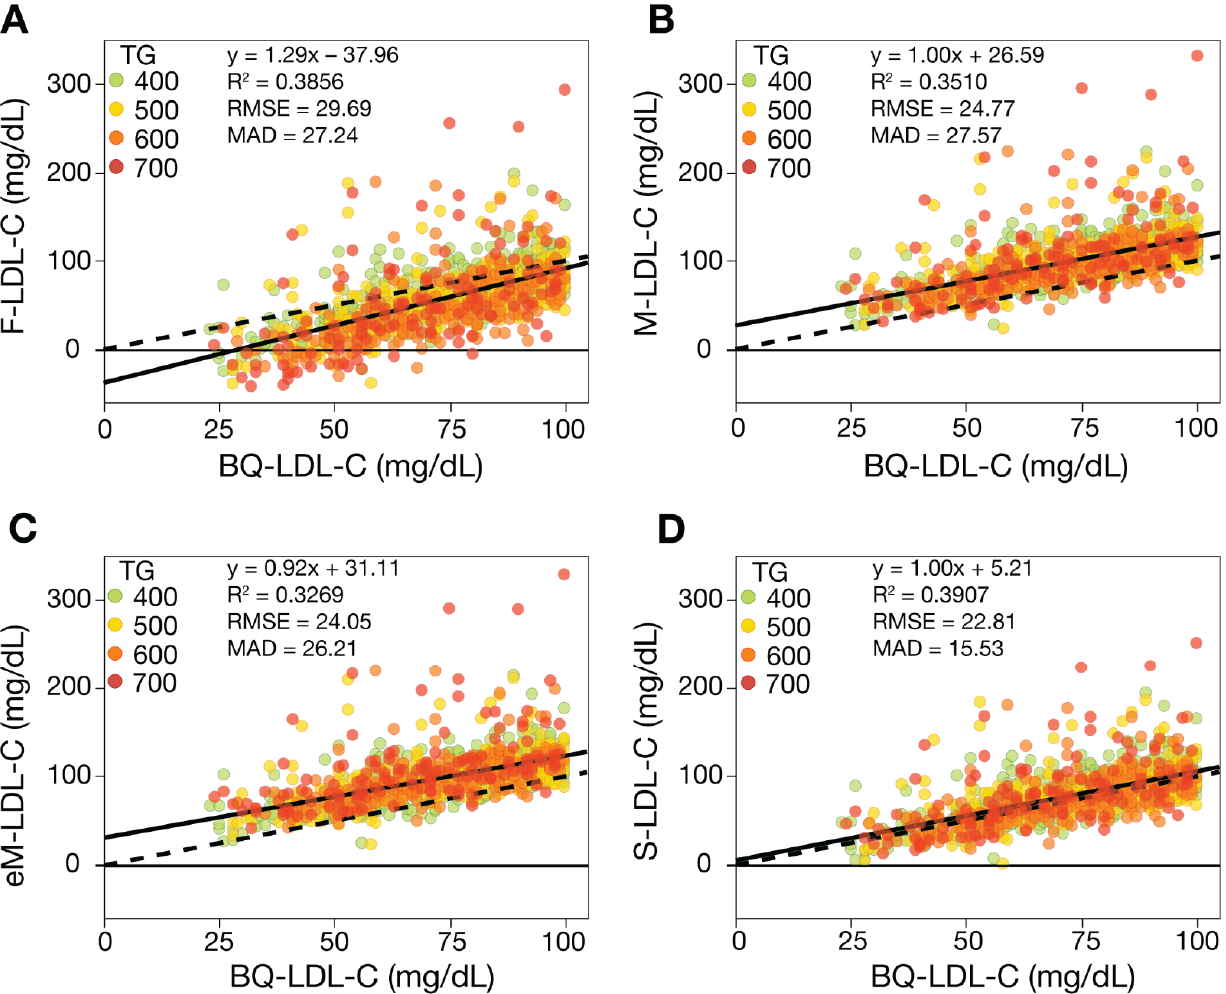
Figure 3. Comparison of estimated LDL-C versus BQ-LDL-C for HTG samples with low LDL-C. LDL-C was calculated from patients (N = 1115) with LDL-C < 100 mg/dL and TG 400–800 mg/dL values by F-LDL-C (Panel A ), M-LDL-C (Panel B ), eM-LDL-C, (Panel C ) and S-LDL-C (Panel D ) equations and plotted against LDL-C as measured by the BQ reference method (BQ-LDL-C). Solid lines are the linear fits for the indicated regression equations. Dotted lines are lines of identity. Results are color coded by TG level with the value in the legend (mg/dL) indicating the start of each interval.